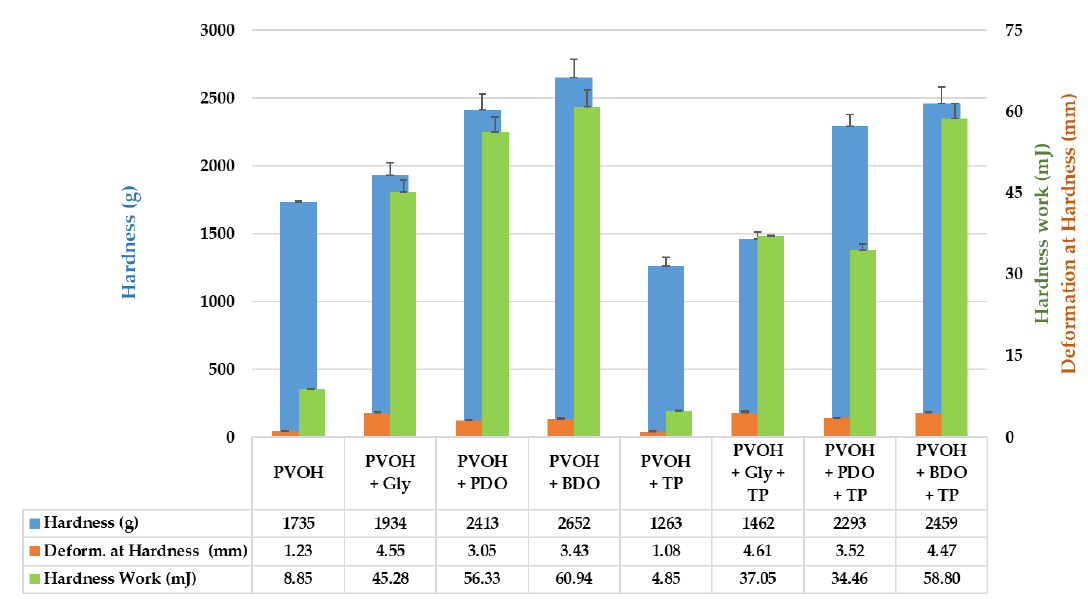
Figure 9. Mechanical properties of PVOH-based biofilms. Reported data represents the average value of three replicates with their standard deviations